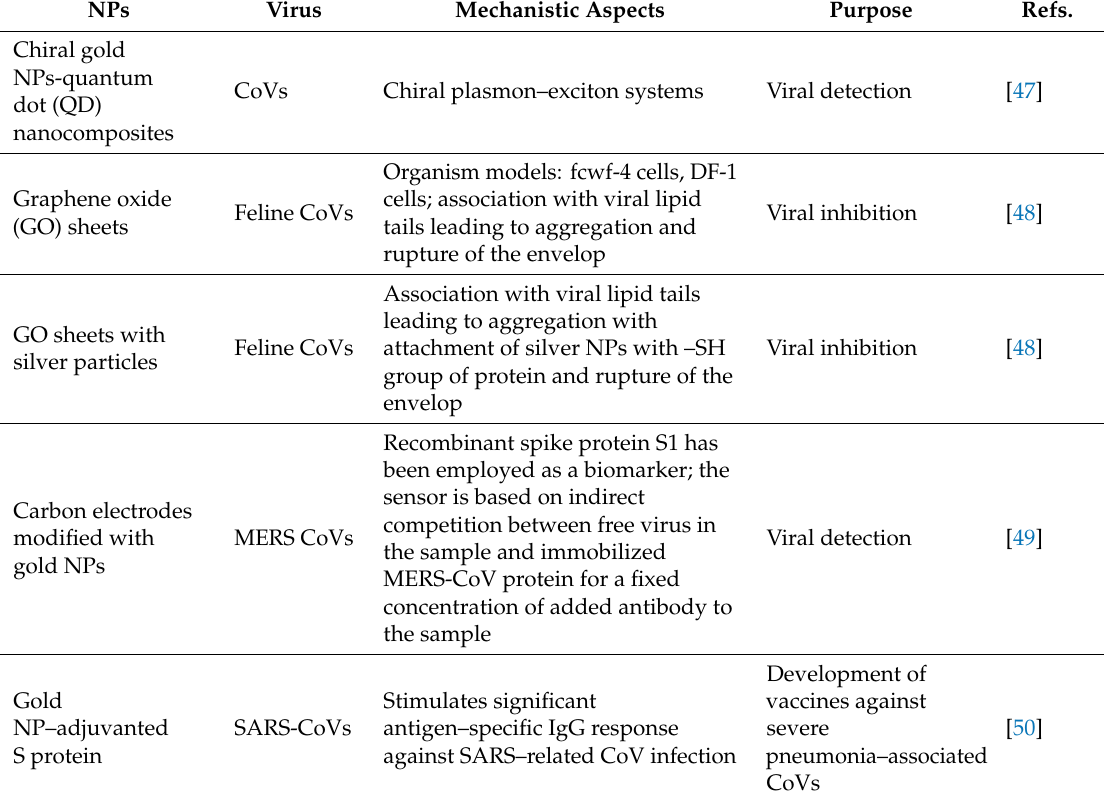
Table 2. Engineered nanomaterials to detect and inhibit